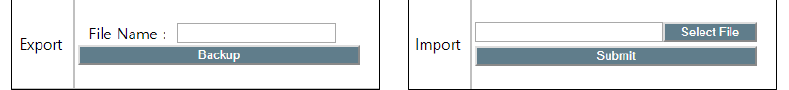
Figure 6. Portability. Left: specifying the exported hardware configuration; right: choosing the hardware configuration to import.